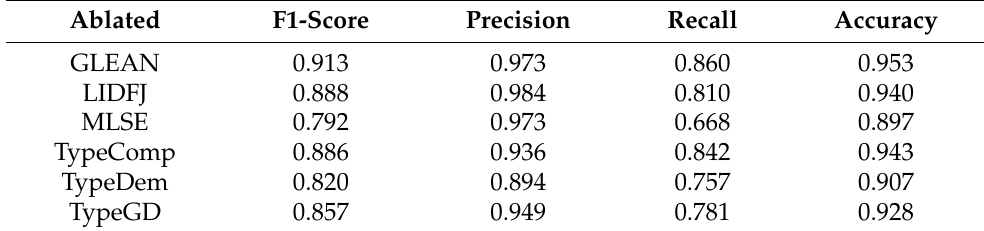
Table 2. Ablation experiment